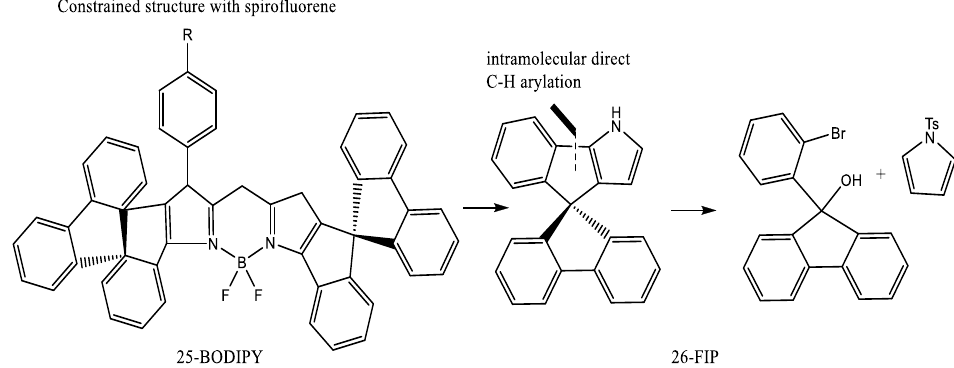
Figure 4. Boradiazaindacene derivatives of 24a , 24b , 24c .